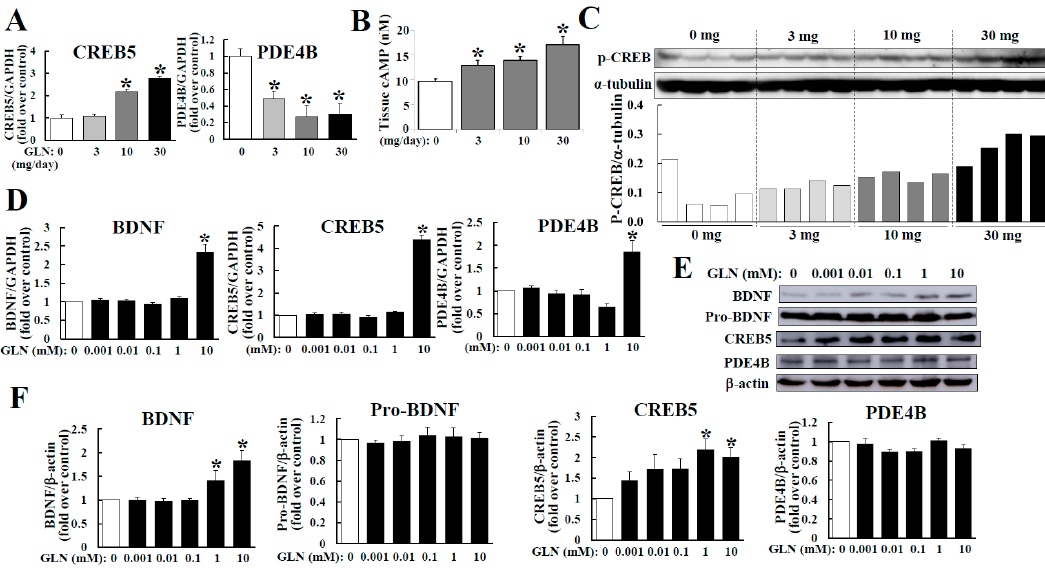
Figure 3. GLN regulation of CREB5 and PDE4B mRNAs, cAMP accumulation and CREB phosphorylation in the hippocampus and the expression of BDNF, CREB5 and PDE4B in the hippocampal cells. The RNA samples prepared from GLN-injected animal’s hippocampus ( A ) and from GLN-treated HT22 cells ( D ) were subjected to RT-PCR to analyze the mRNAs of BDNF, CREB5 and PDE4B. The cAMP concentration ( B ) and CREB phosphorylation ( C ) in hippocampal tissues were determined. Protein expression of BDNF, CREB5 and PDE4B in GLN-treated HT22 cells were analyzed by Western blotting ( E , F ). The results represent the means ± S.D. ( n = 8). *, p < 0.05 compared with the 0 mg ( A , B , C ) or the 0 mM group ( D , F ).